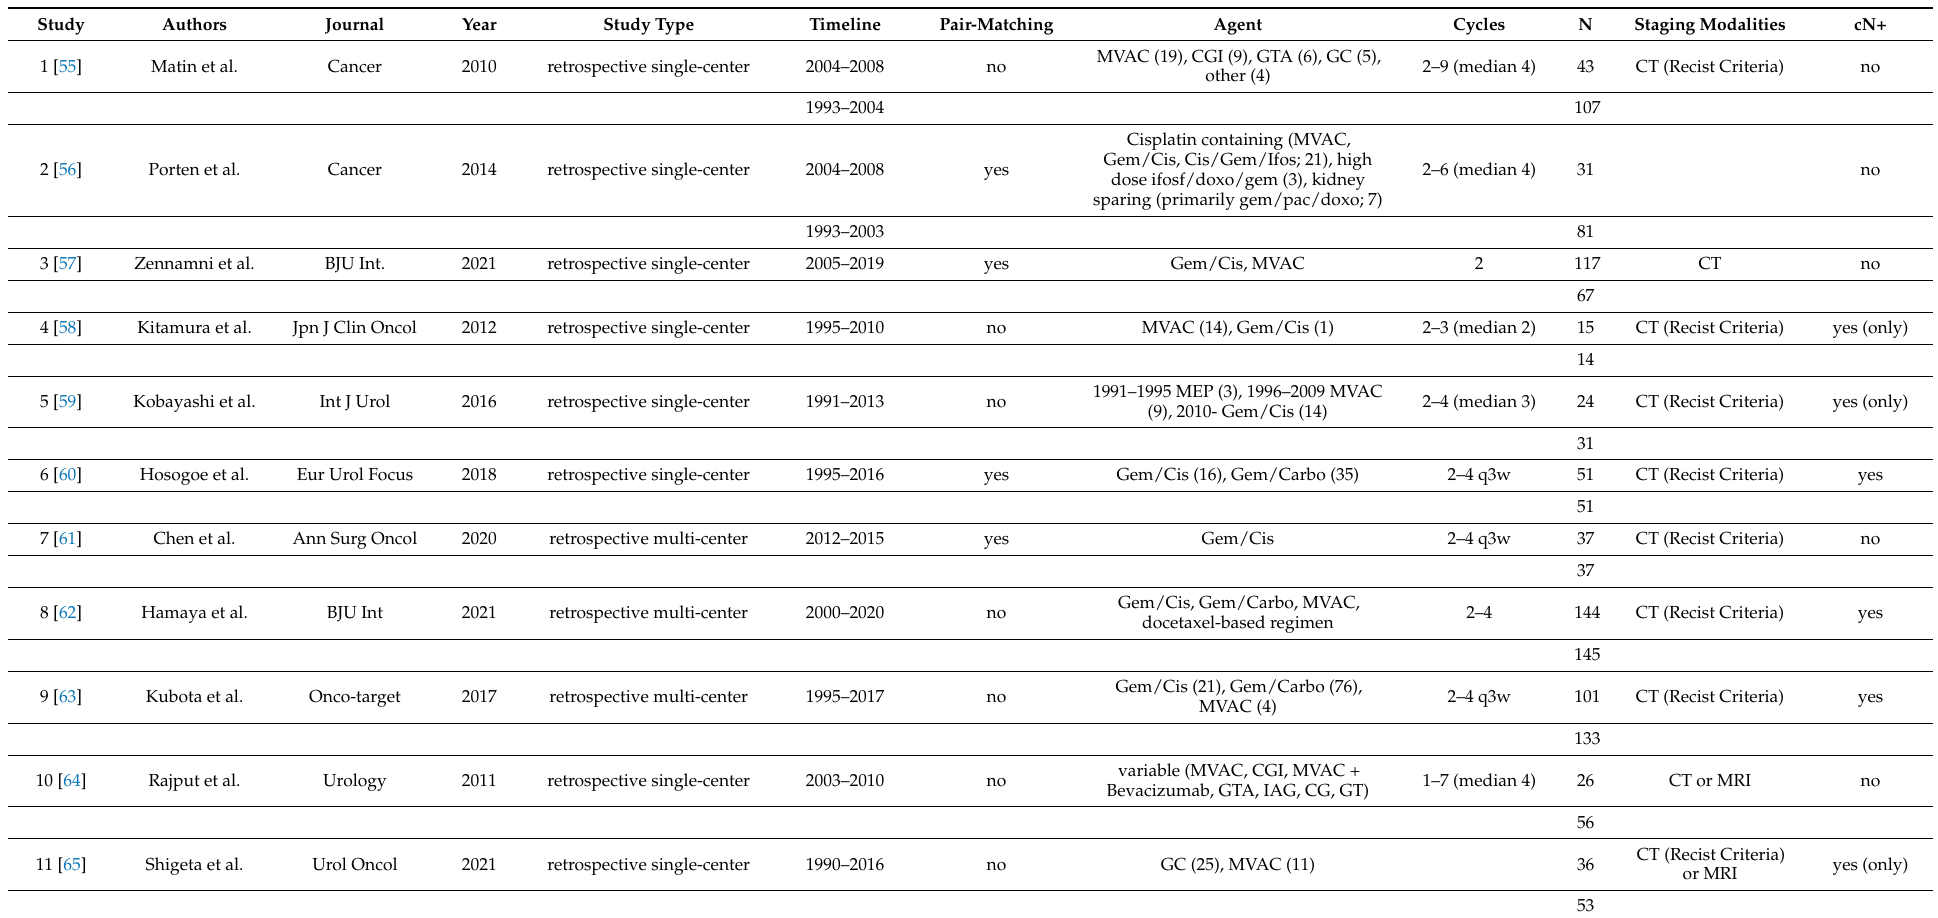
Table 1. Basic study